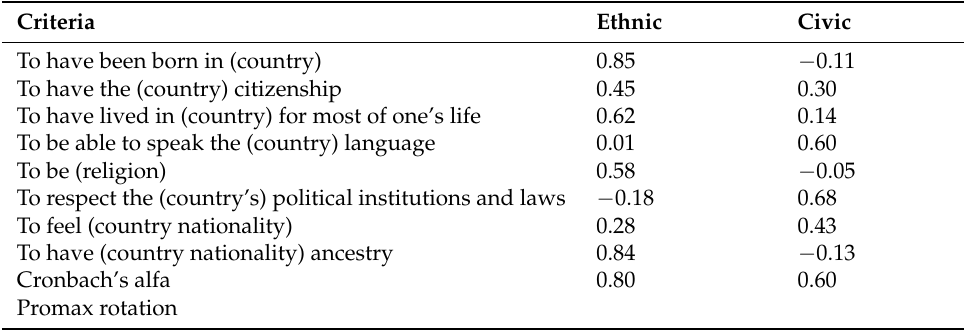
Table 2. Factor loadings for EFA. ISSP 2003 and 2013 criteria for being a truly